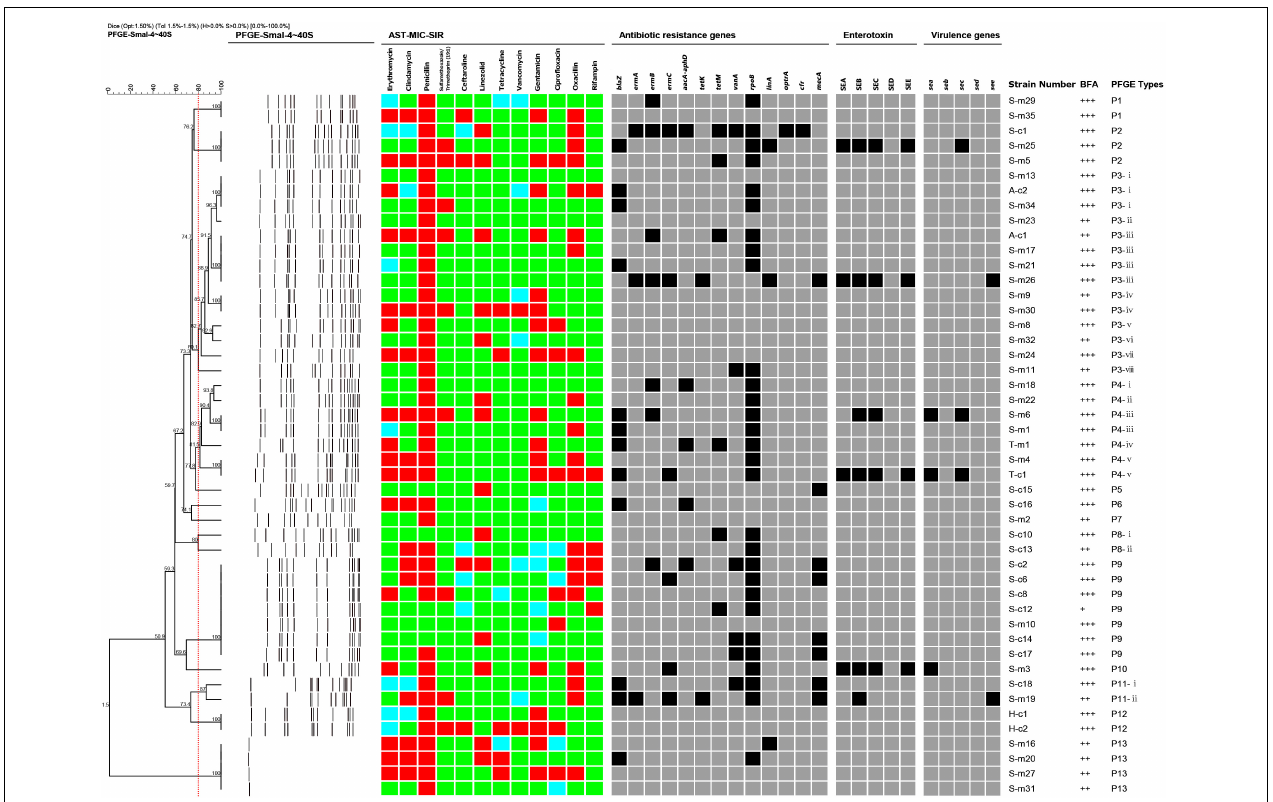
FIGURE 1 | Dendrogram of PFGE patterns and antimicrobial susceptibility testing (AST), antibiotic resistance genes, virulence genes, enterotoxin production, biofilm forming and molecular characterization of 47 representative S. aureus strains isolated from raw milk in northern Xinjiang, China. The 47 isolates were grouped into 13 pulsotypes (P1–P13) by the PFGE patterns and all had more than 80% similarity. The AST results are shown as different colors according to the MIC values of the isolates to different antimicrobial agents. Green squares indicate susceptibility; blue squares indicate intermediate; and red squares indicate resistance. The detection of antibiotic resistance genes, virulence genes, and biofilm forming were summarized by a heat map. Black squares denote that the studied genes were detected in those isolates, or those isolates produced those types of enterotoxins. Gray squares denote that the isolates lacked the studied genes or could not produce those types of enterotoxins. BFA represents biofilm forming ability.